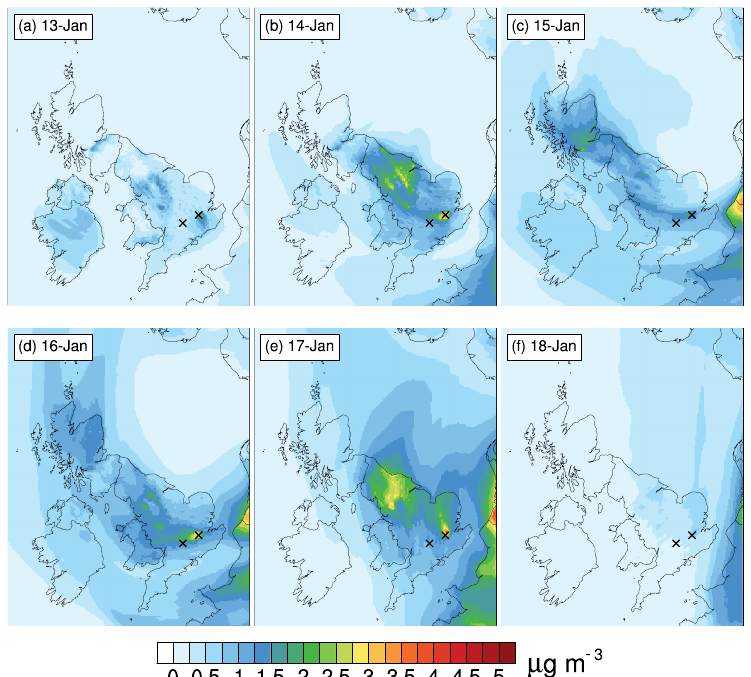
Figure 10. Same as Fig. 9, but for the combRedist